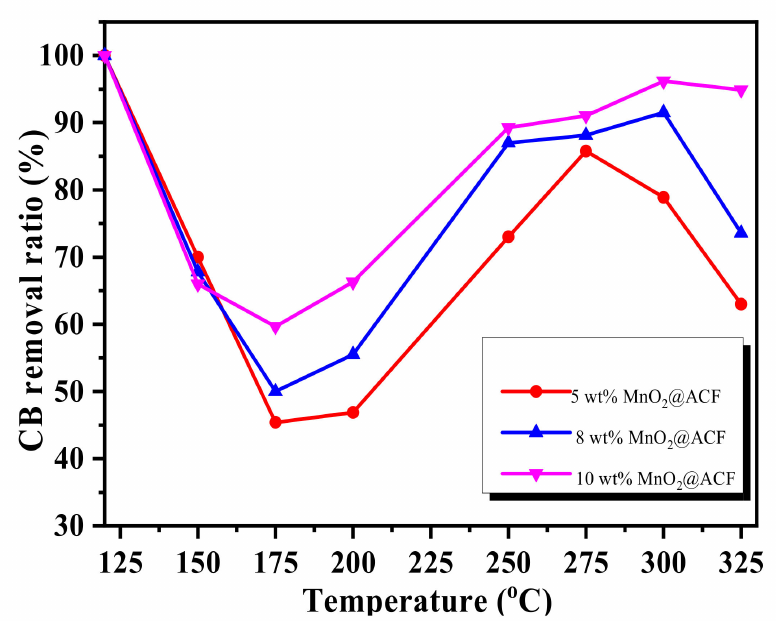
Figure 9. Adsorption/catalytic oxidation of CB over MnO 2 @ACF with different amounts of man- ganese oxide. ( C inlet,CB = 5000 ppm, Gas flow rate = 100 SCCM, GHSV = 20,000 h − 1 , 21% O 2 , N 2 balance, dwell time = 3